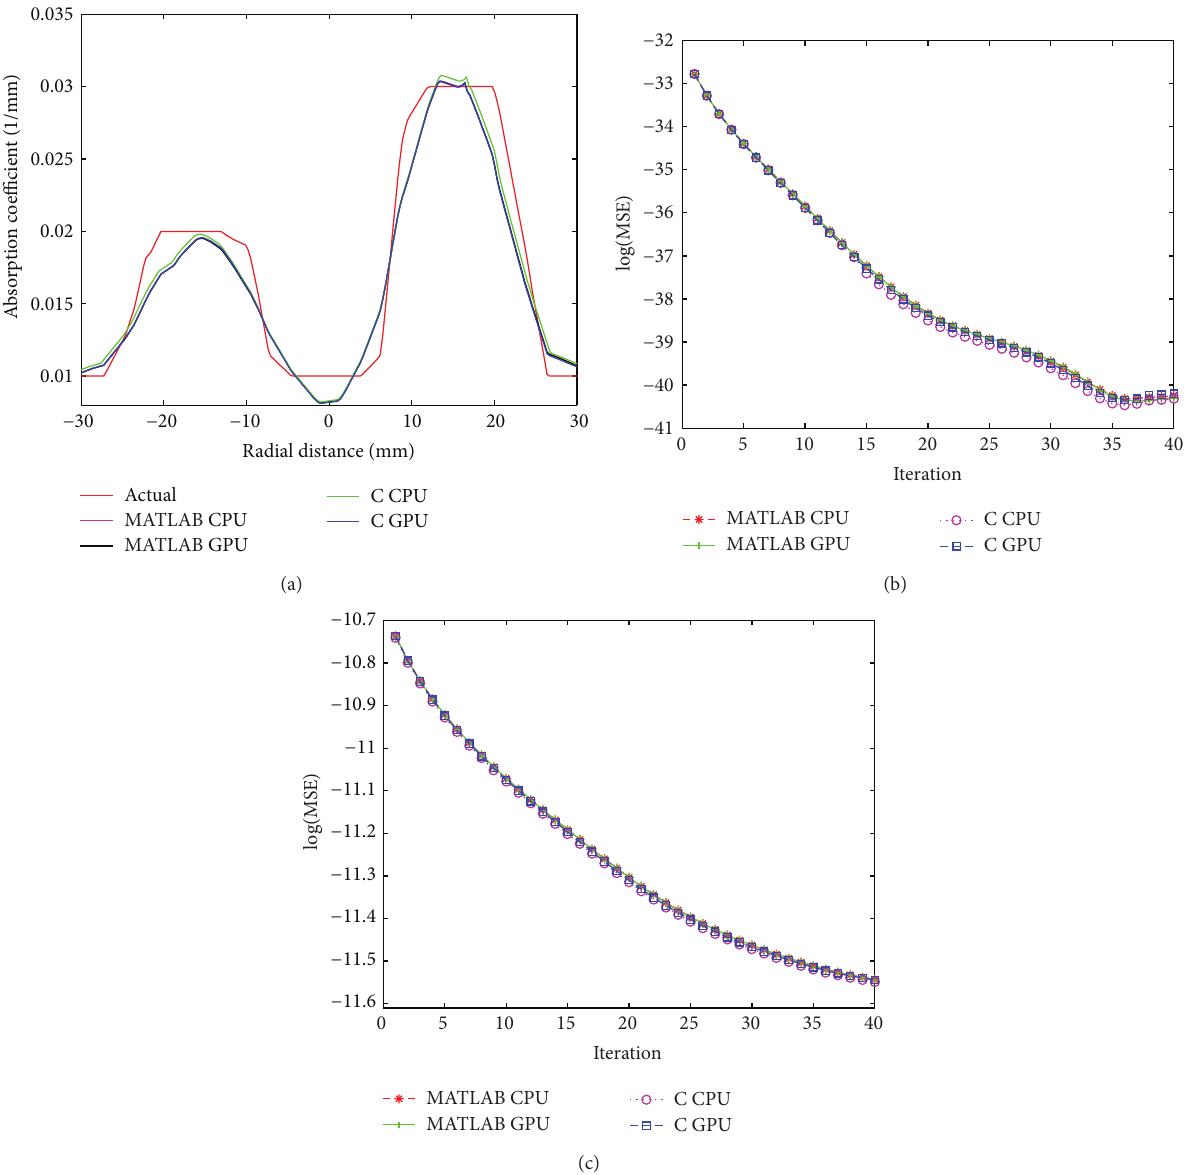
Figure 5: For simulation phantom, (a) cross-sectional line through the center of inhomogeneities 1 and 2, (b) MSE between computed measurements and the experimental measurement data as iteration proceeds ( 𝑀 𝐶 and 𝑀 𝐸 ), and (c) MSE between 𝜇